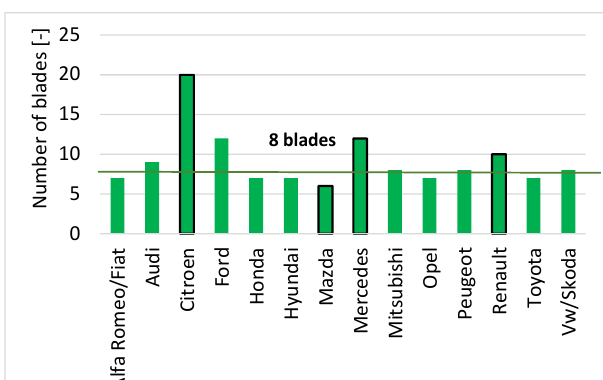
Fig. 4. Number of blades in each CP